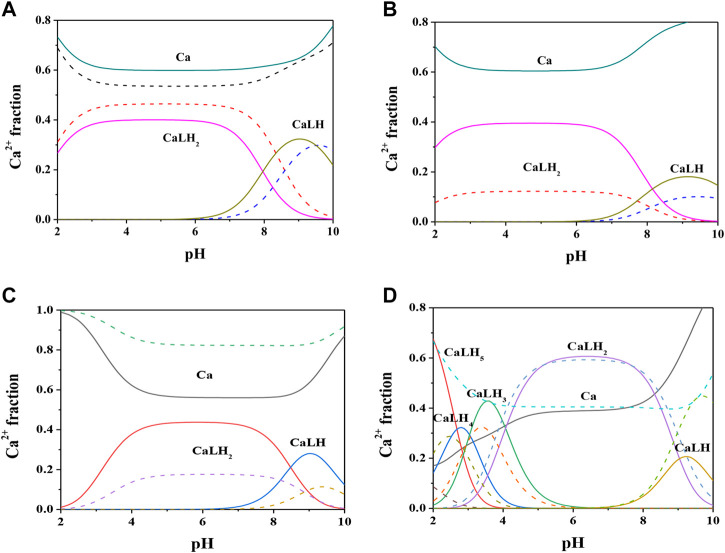
Speciation diagrams of Ca2+-ligand (L) systems at t = 15 °C (dotted lines) and t = 37 °C (solid lines), CM = 2 mmol L−1, CL = 4 mmol L−1, I = 0.15 mol L−1 in NaCl (A) L = Cys
(B) L = PSH
(C) L = GSH
(D) L = GSSG.